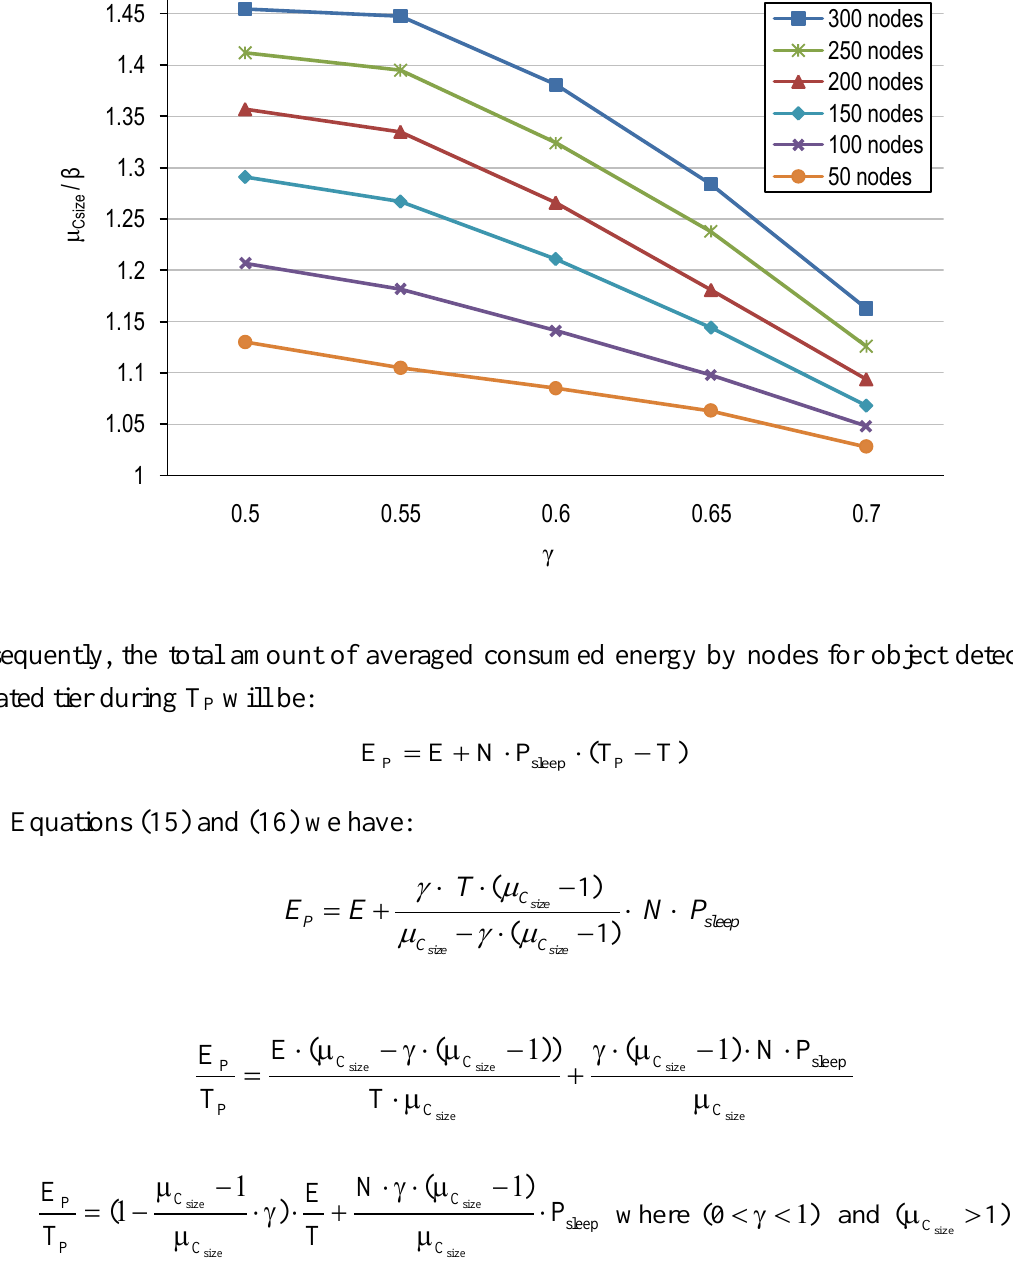
Figure 11. The average of coefficient 